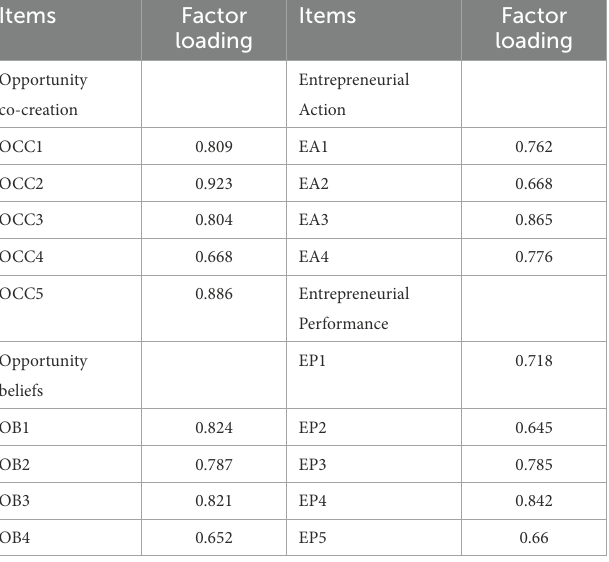
TABLE 2 Results of the confirmatory factor